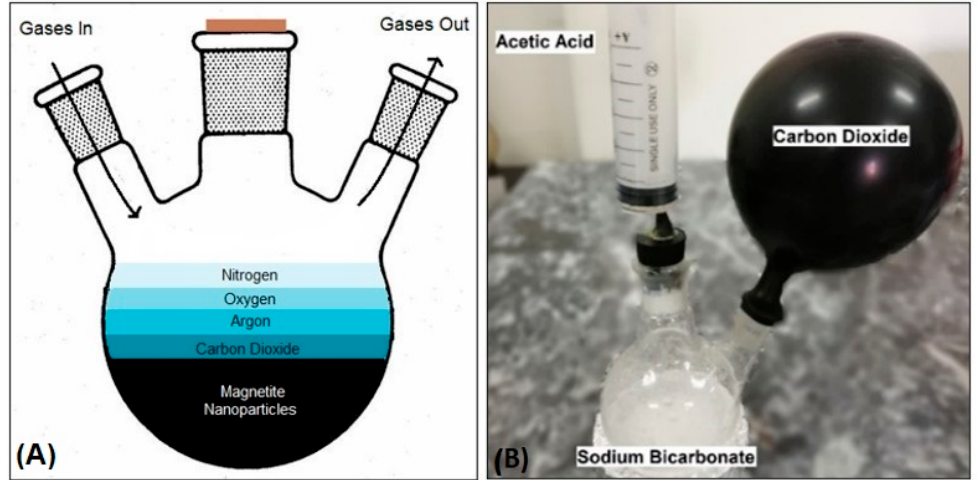
Figure A1. (A ) The diagram shows different gases lighter and heavier than air. ( B ) Production of carbon dioxide gas.